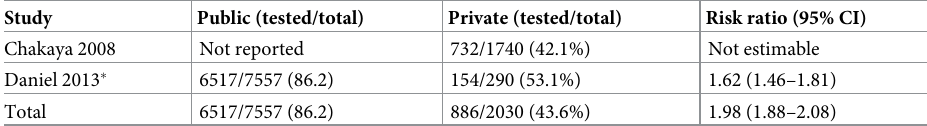
Table 1. Tuberculosis patients tested for HIV by sector.